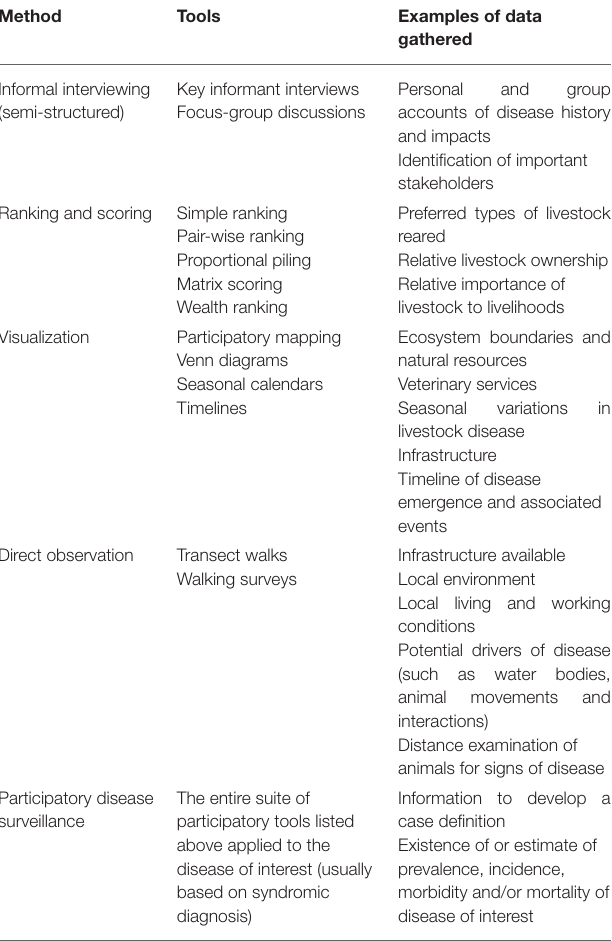
TABLE 3 | A compilation of PE methodology and training resources available free of charge online. PE